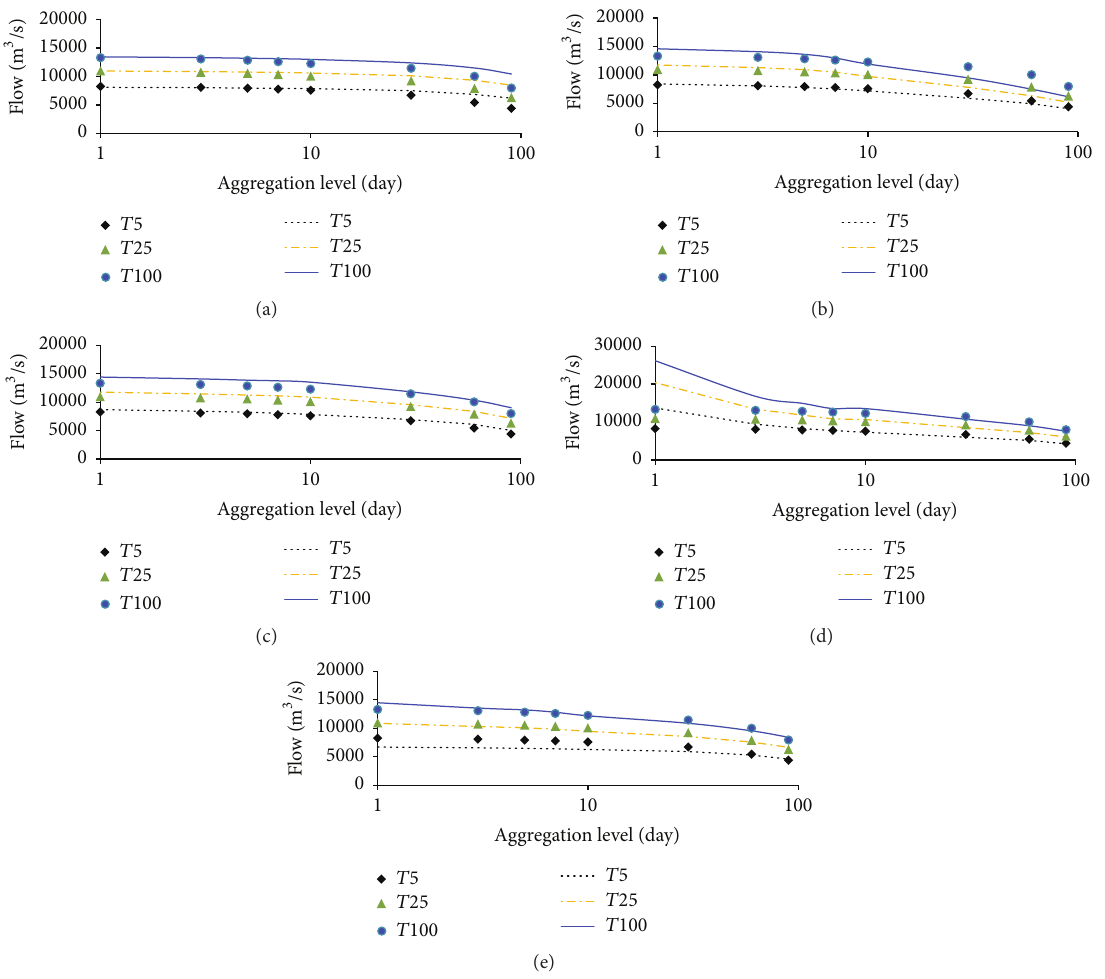
Figure 11: QDF relationships for observed peak high flows and modeled flows from (a) AWBM, (b) IHACRES, (c) SAC, (d) SIMHYD, and (e) TANK. Markers and lines are for observed and modeled flows, respectively. In the legend, for example, 𝑇5 denotes 𝑇 -year curve for 𝑇 = 5